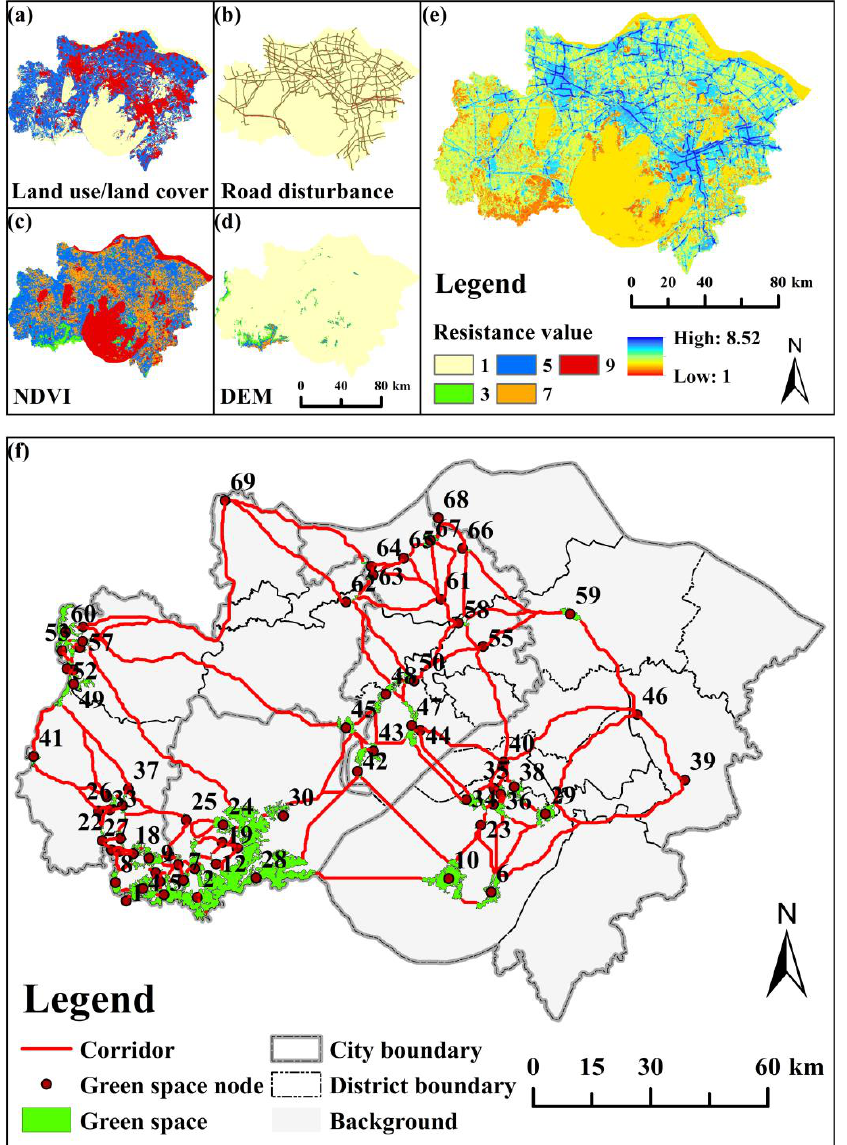
Figure 2. Maps of greenspace ecological networks (GENs) and resistance surface simulation in the Su-Xi-Chang area. ( a – d ) are the individual resistance maps generated by the selected factors including land use/land cover, distance to the main road, elevation, and vegetation (represent by the normalized differential vegetation index i.e., NDVI.); ( e ) is the comprehensive resistance map weighted overlay of those four maps; ( f ) showed the overall GENs in the study area.